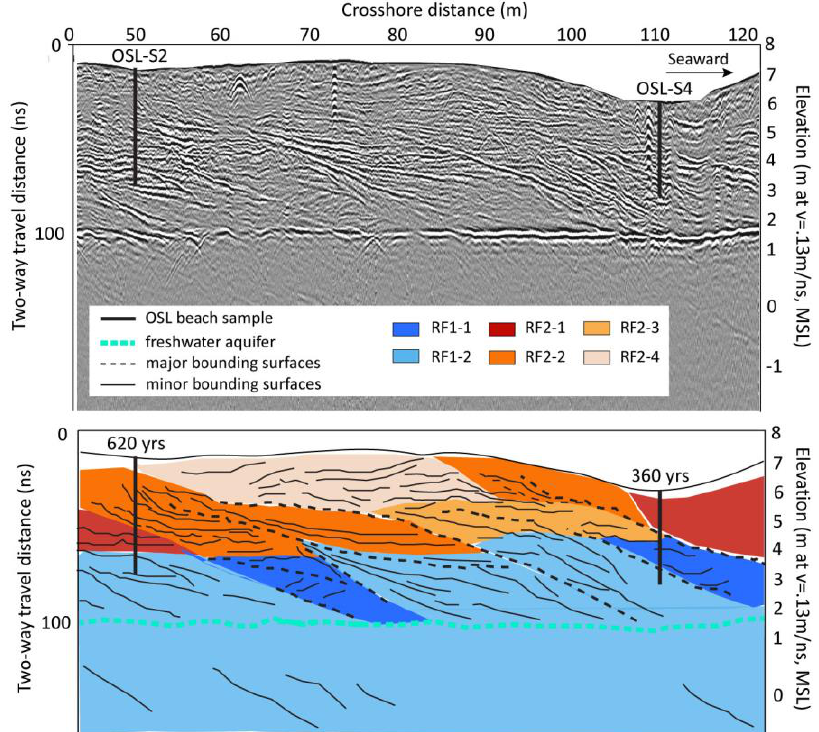
Figure 6. The upper panel shows part of the radargram corresponding to GPR-ST (i.e., southern transect in Figure 3) measured across the coastal plain at Fonte da Telha. The lower panel presents the interpretation of the radargram showing identified radar facies and the position of the sediment samples for dating and their ages.